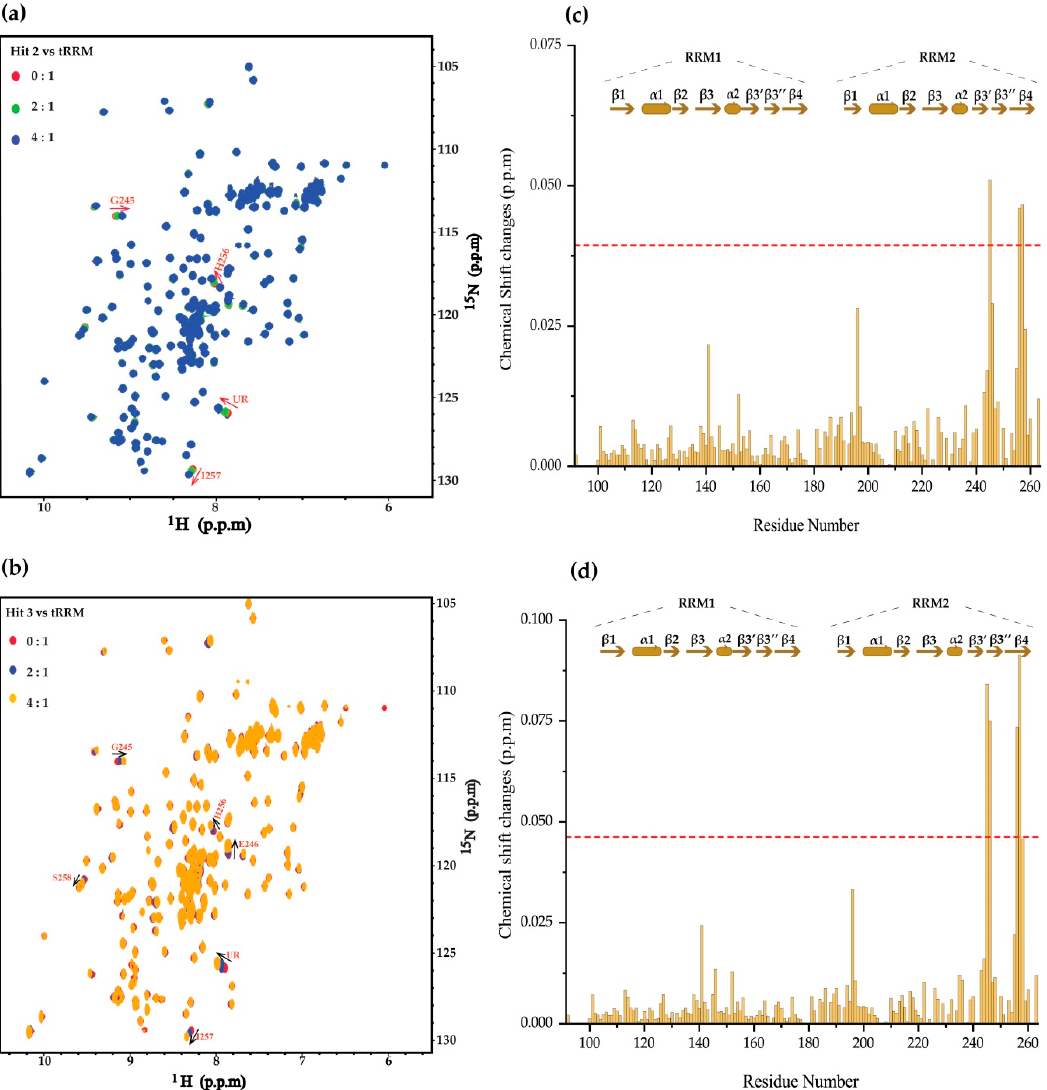
Figure 3. Chemical shift perturbations of tandem RRM upon binding of hit 2 and 3. ( a , b ) The chemical shift perturbations of TDP-43 tandem RRM domain induced by titration of hit 1 and 2, respectively. Annotated are the hits: Protein molar ratios. UR stands for unassigned residue. ( c , d ) Residue-by-residue chemical shift changes of tandem RRM at the hit/protein molar ratio of 8:1 for compound 2 and 3, respectively. The red dashed lines represent two standard deviations above the averaged chemical shift changes of residues.